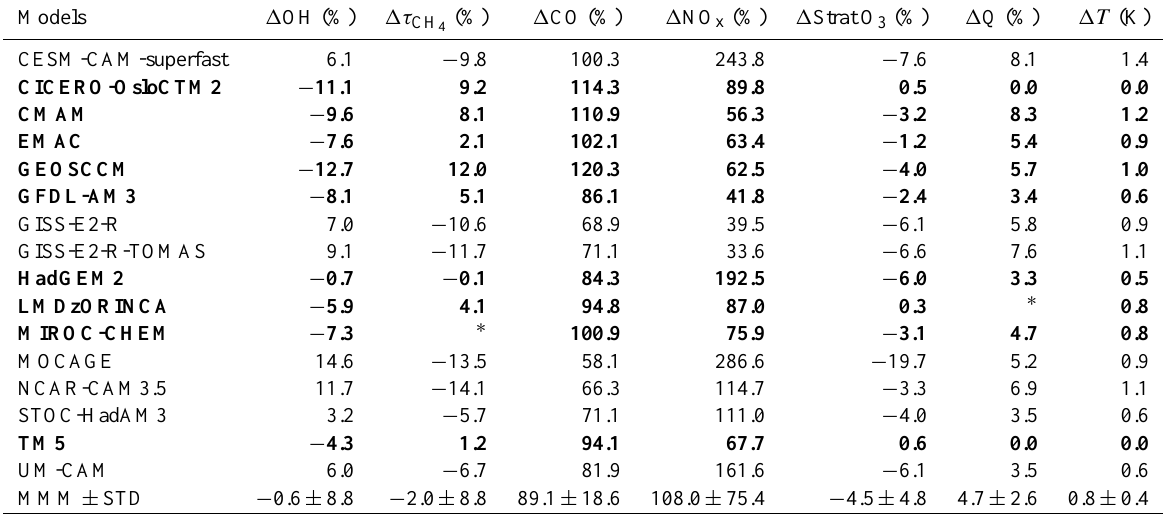
Table 4. Preindustrial (1850) to present-day (2000) changes in global mean tropospheric OH, tropospheric methane lifetime ( τ CH NO x burdens, stratospheric ozone column (Strat O 3 ), humidity (Q), and temperature ( T ). Absolute changes in airmass-weighted temperature are given, while the rest of the quantities are expressed as percentage changes relative to 1850. Models that simulate reductions in present-day OH relative to preindustrial are shown in bold. A cell with ∗ means that the model did not report that quantity.